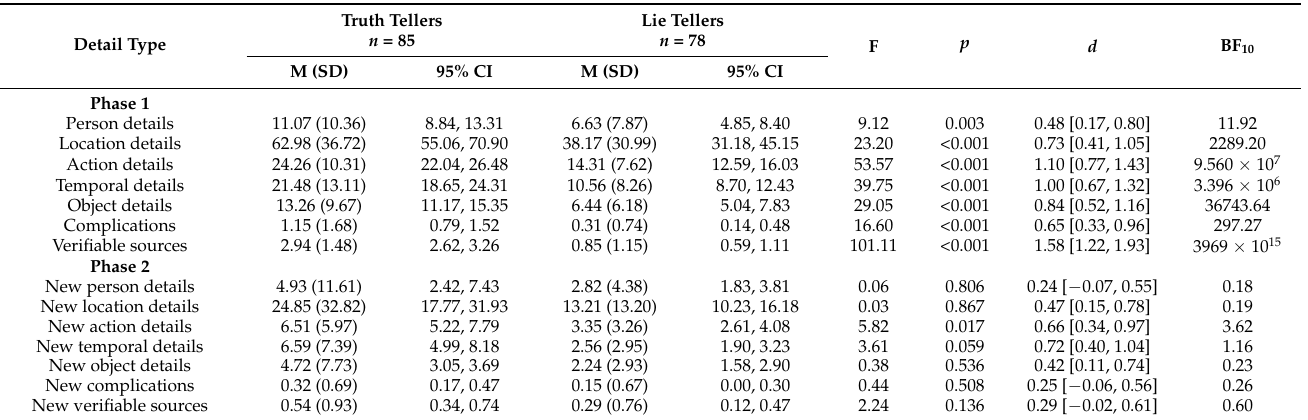
Table 3. Descriptive and Inferential Statistics for the Dependent Variables as a Function of Veracity in Phases 1 and 2.